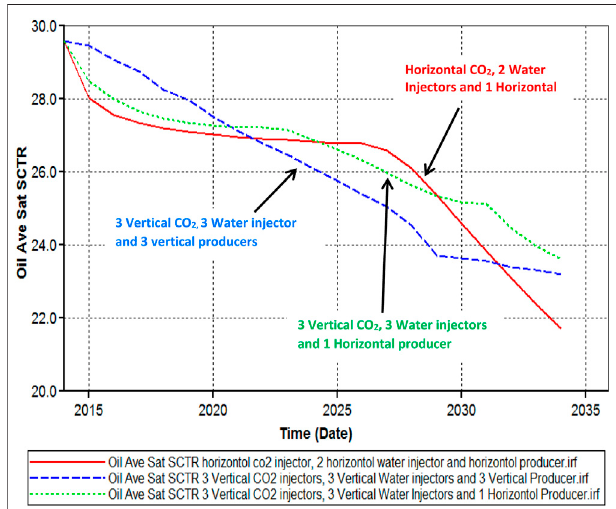
FIGURE9| Averageoilsaturationvs. timeforthethreeexaminedcases. In all cases, CO 2 was injected into the aquifer which was followed by water injection.